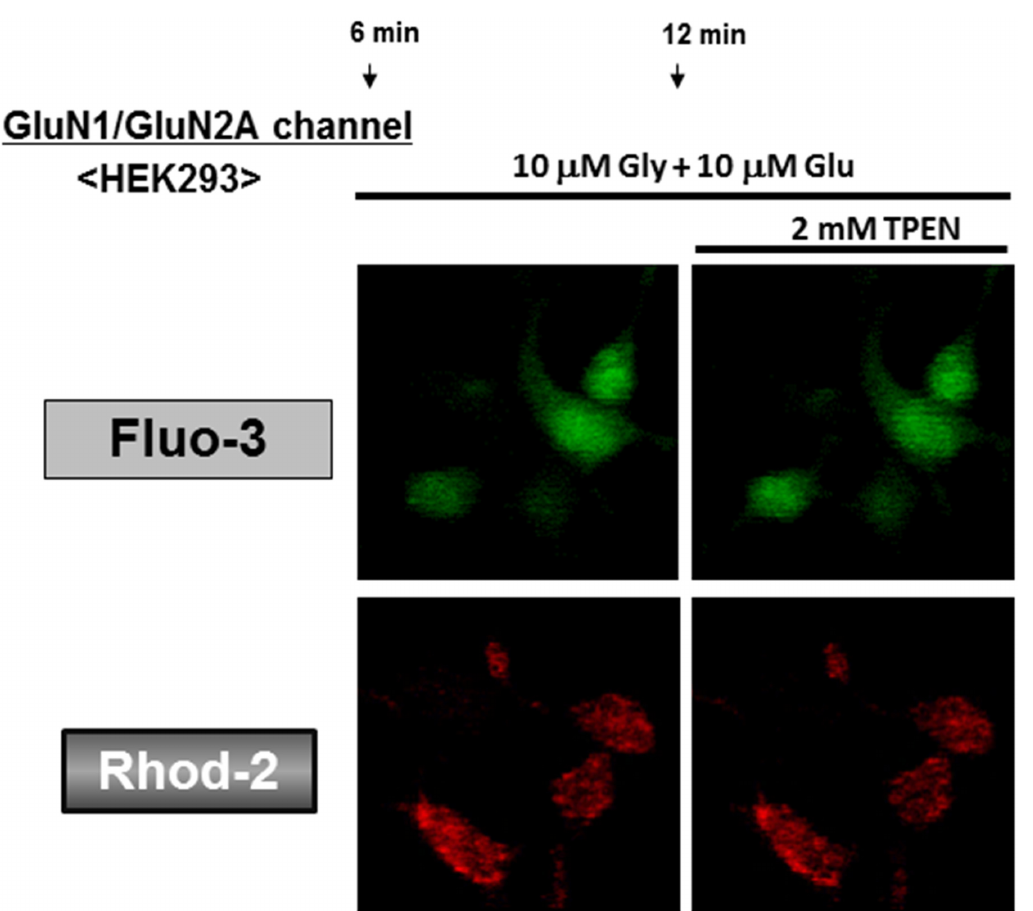
Fig 11. Micrographic pictures of both Fluo-3 and FluoZin-3 fluorescence in HEK293 cells with artificial NMDAR. Typical pictures are shown here.